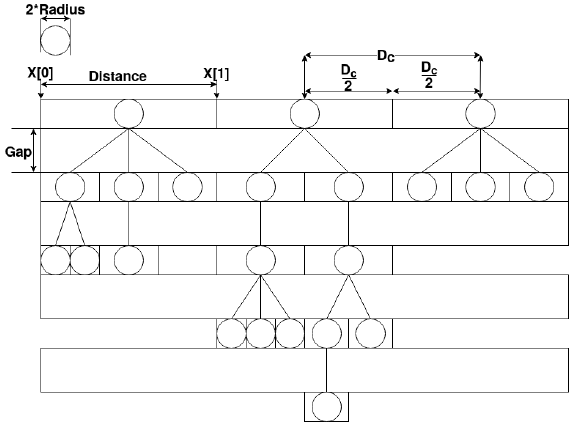
Figure 7. Parameter For Forest